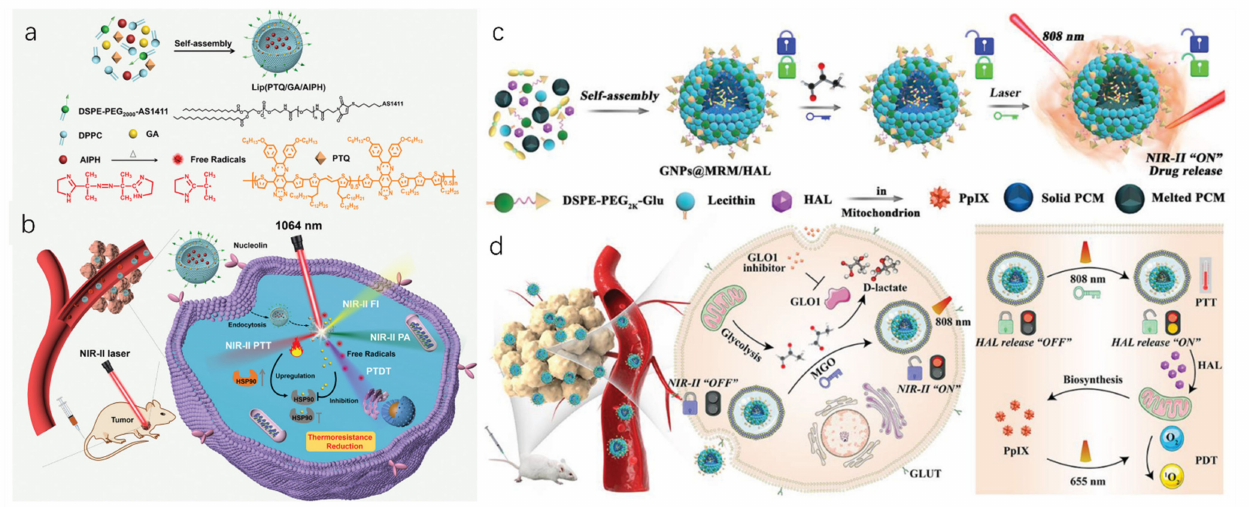
Figure 4. ( a ) Synthesis of NIR-II light excitation Lip (PTQ/GA/AIPH) nanoparticles for fluorescence imaging/photoacoustic imaging-guided combination therapy. ( b ) Schematic diagram of NIR-II light excitation FI/PAI imaging-guided photothermal therapy (PTT) and photonic thermodynamic therapy (PTDT) for triple-negative breast cancer in vivo. ( c ) Synthesis of the GNPs@MRM/HAL nanoparticles and illustration of their “dual lock-and-key” properties. ( d ) Schematic diagram of GNPs@MRM/HAL nanoparticles in NIR-II fluorescence imaging-guided phototherapy of cancer. Adapted with permission from [73]. Copyright 2021 John Wiley and Sons. Adapted with permission from [74]. Copyright 2022 John Wiley and